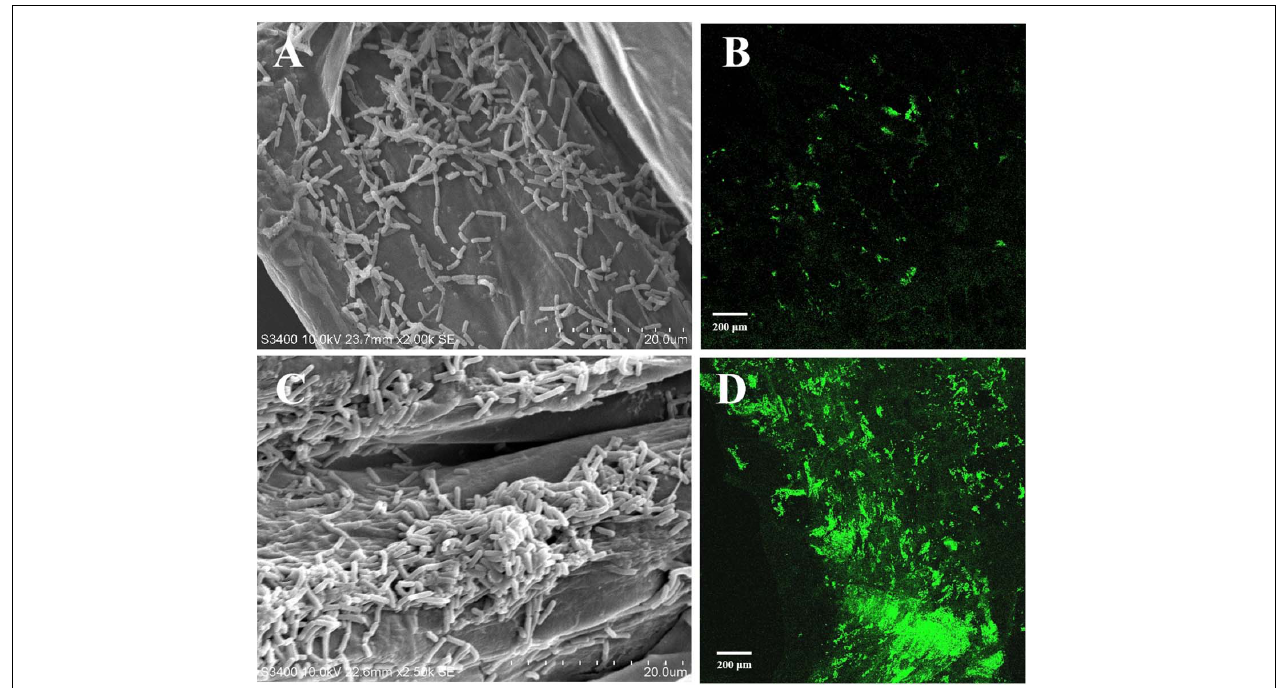
FIGURE 4 | Root colonization assay of B. velezensis GUMT319. (A) Scanning electron microscope (SEM, HITACHI S-3400N) images of pepper seedling roots colonized by strain GUMT319. (B) Confocal laser scanning microscope (CLSM, Olympus FV10i) images of pepper seedling roots colonized by GUMT319-gfp.